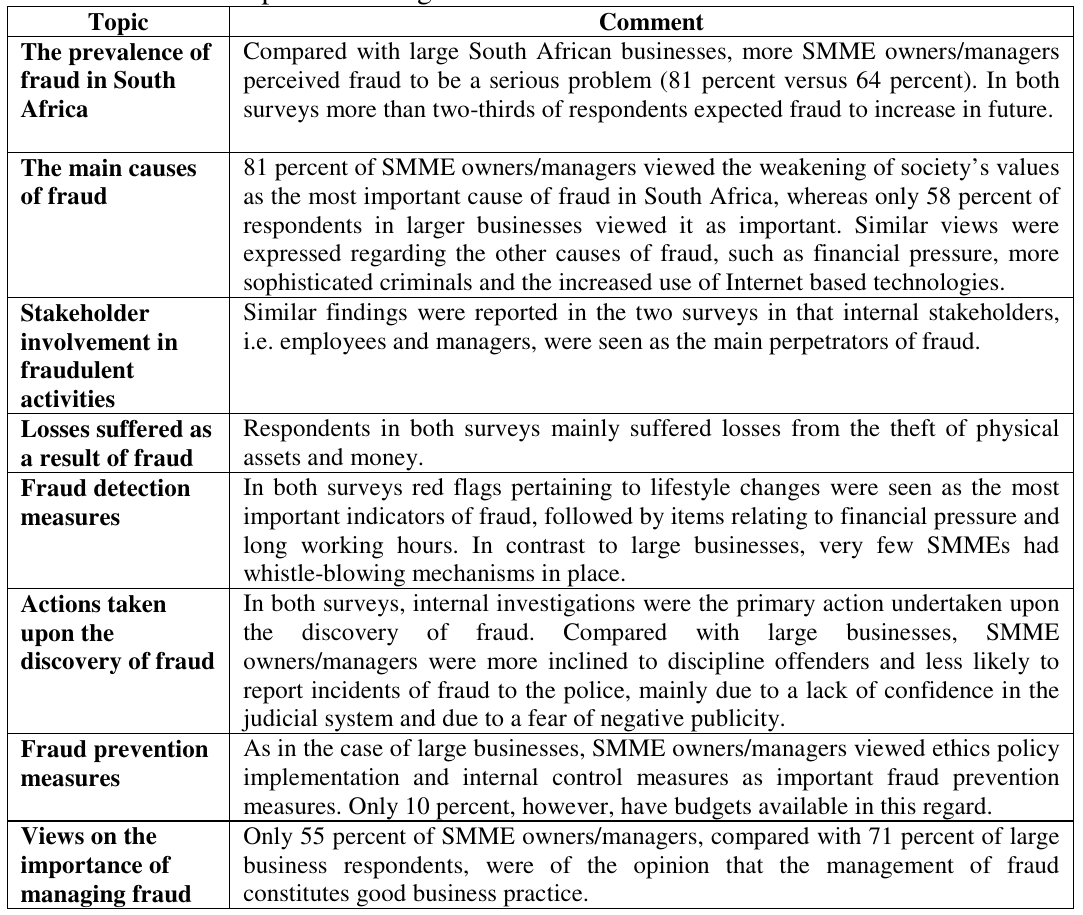
Table 6: Salient empirical